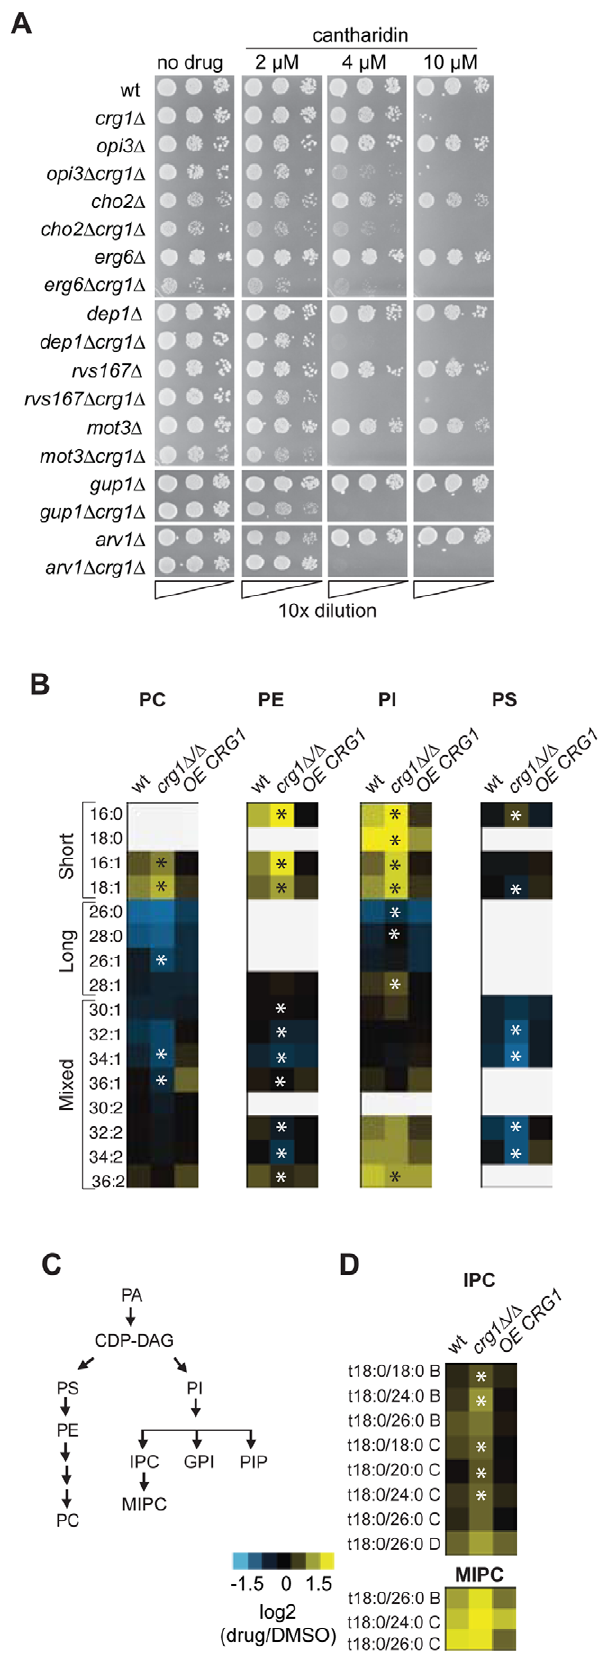
Figure 5. Crg1 is important for lipid homeostasis during cantharidin stress. (A) CRG1 is synthetically lethal with lipid-related genes in the presence of cantharidin. Cells were normalized to an equivalent OD 600 ,10-fold diluted, spotted onto synthetic complete defined medium containing cantharidin and incubated at 30 u C. (B) Comparative phospholipid profiles of wild type and crg1 mutants in response to cantharidin. Cells grown to mid-exponential phase in YPD were treated with cantharidin (250 m M) for 2 hours. Lipid standards were added to the cells, and extracted lipids were measured using ESI- MS/MS. The quantities of lipid species are expressed as ion intensities relative to the levels in DMSO, and converted to a log2 scale. Data are the average of three samples. Statistical significance in the abundance of lipid species in the presence of cantharidin between wild type and mutants was determined using Kruskal-Wallis test, * P -value , 0.05 (Table S4). (C) A simplified diagram of phospholipid biosynthesis linked to sphingolipid biosynthesis. PIs species contribute to biosynthesis of complex sphingolipids, GPI anchors, and PIPs. (D) Comparison of sphingolipid profiles of wt, crg1 D / D and CRG1 -overexpressing crg1 D / D mutants in the presence of cantharidin (250 m M). The suffixes -B, -C, and -D on IPC and MIPC denote hydroxylation states, having two, three, or four hydroxyl groups, respectively. Statistical significance in the abundance of lipid species in the presence of cantharidin between wild type and mutants was determined using Kruskal-Wallis test, * P - value , 0.05 (Table